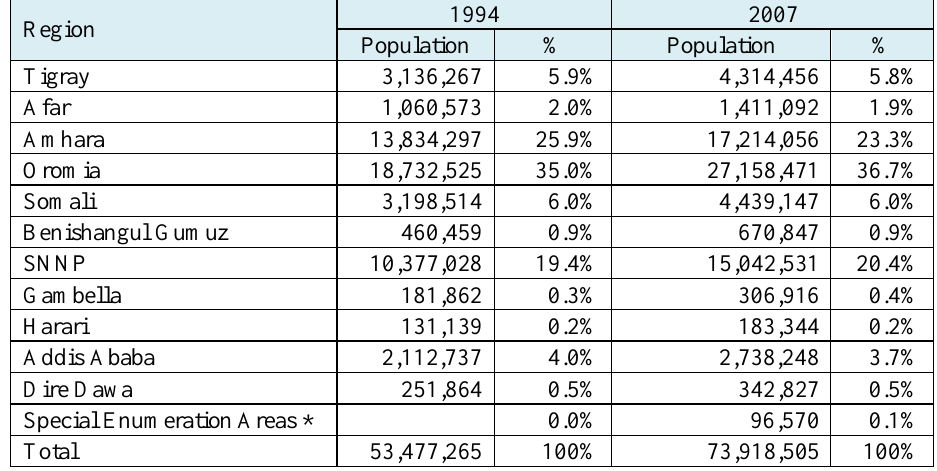
Table 2-1: Population by Region (1994, 2007) (number,